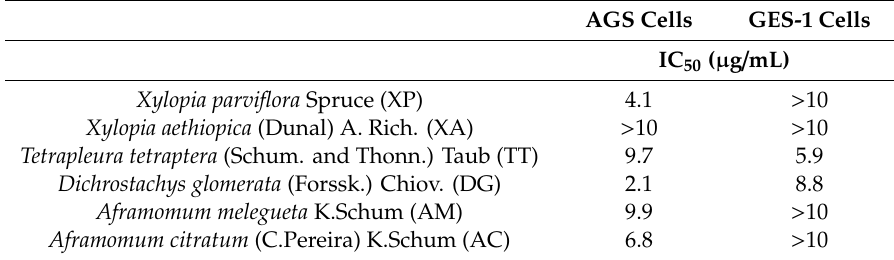
Table 1. Half-maximal Inhibitory Concentration (IC 50 ) ( µ g / mL) of the extracts on the TNF α -induced NF- κ B driven transcription in human gastric adenocarcinoma (AGS) and gastric epithelial (GES-1) cells.